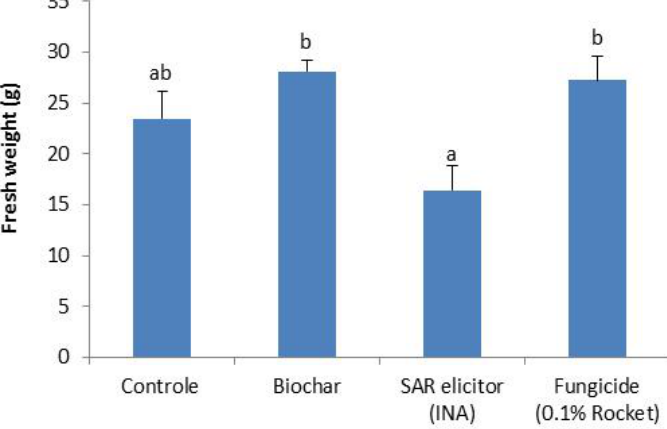
Figure 5. Average fresh weight of Gerbera after six weeks. No significant effects of biochar addition were found compared to the untreated plants (Tukey’s test, p < 0.05). Treatments which do not share the same letters a or b differ significantly (Tukey’s test, p < 0.05).